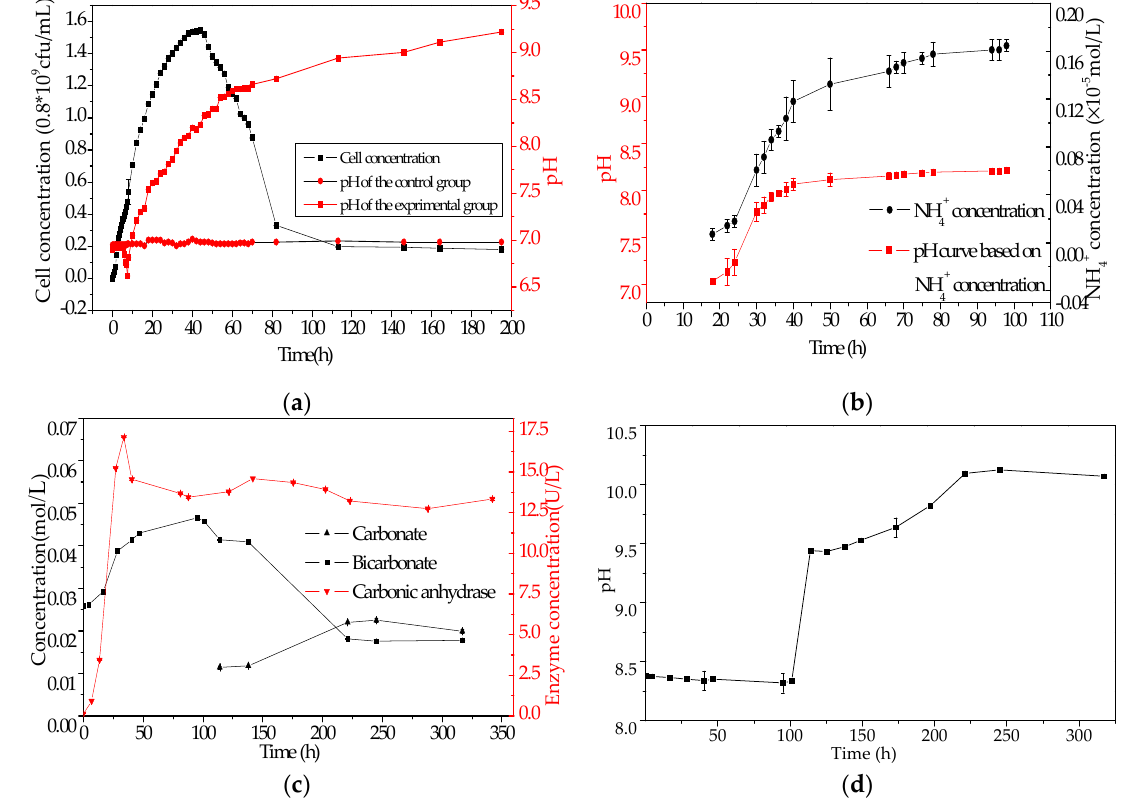
Figure 3. Physiological and biochemical characteristics of the B. subtilis J2 strain. ( a ) Growth curve and pH curve; ( b ) the concentration of ammonium and pH curve based on the concentration of ammonium; ( c ) concentrations of CA and bicarbonate and carbonate ions; ( d ) pH curve based on the concentration of bicarbonate and carbonate ions.